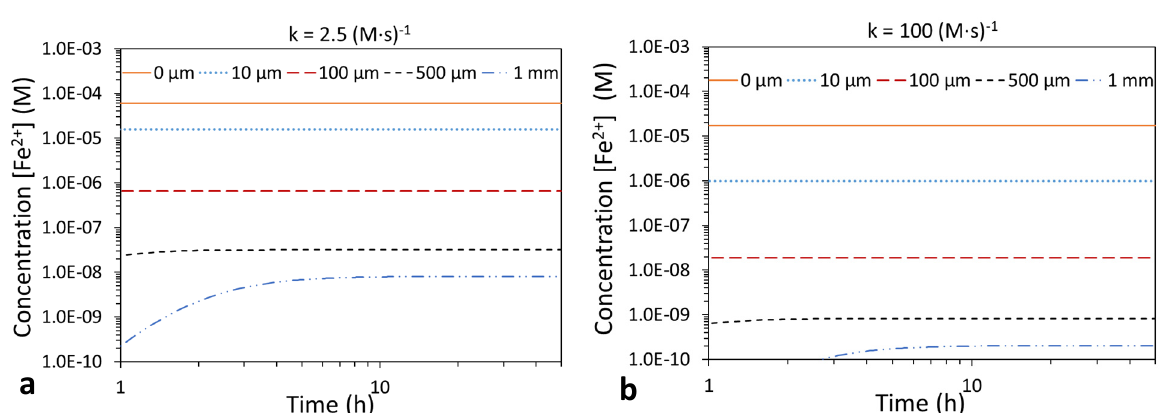
Figure 3. Concentration of Fe 2+ over time, at different distances from the steel surface (0, 10, 100, 500 µm and 1 mm). Process modeled for D eff = 1∙10 ‐7 cm 2 /s and different oxidation kinetic constants (eq. 7): a) k= 2.5 1/(M∙s) (slow), b) k= 100 1/(M∙s) (fast). The figures show that after 10h the concentration of Fe 2+ has achieved the steady state for all considered distances. Also, the results show that a higher Fe 2+ oxidation rate leads to a lower concentration of Fe 2+ at all depths.